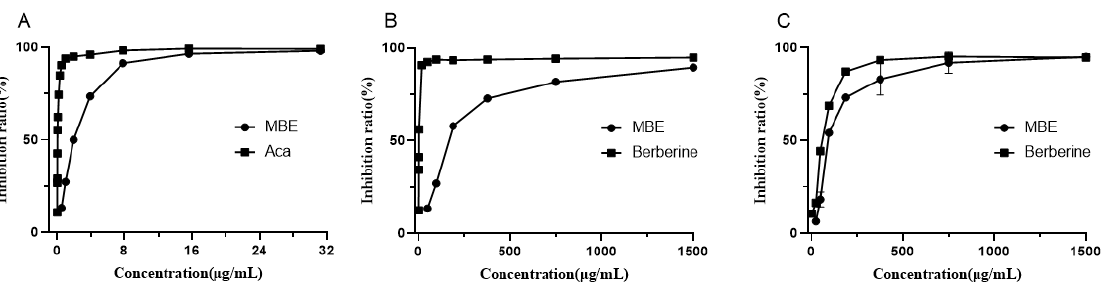
Figure 3. Enzyme inhibitory activity of MBE. ( A ), α -glucosidase; ( B ), AChE; ( C ), BChE.